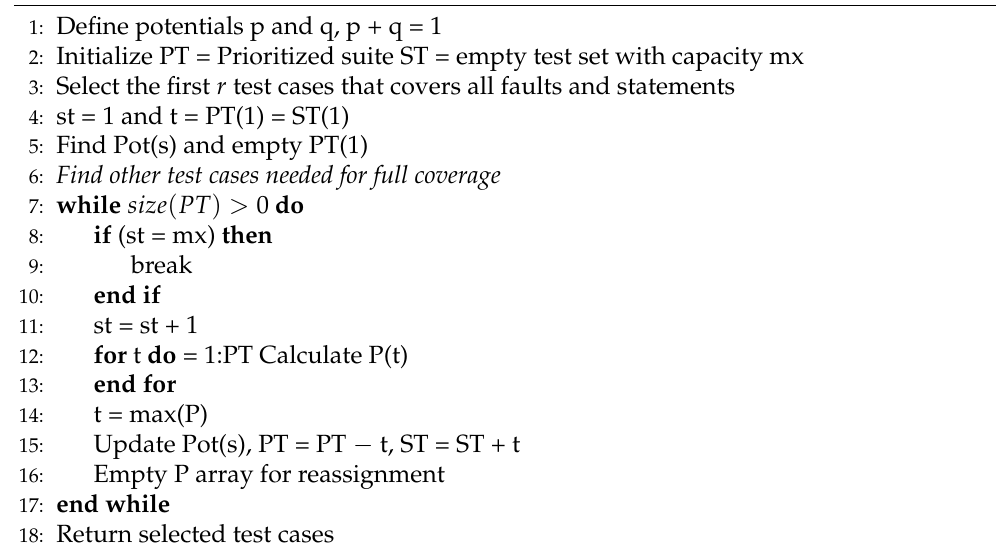
Algorithm 1 Adaptive Test Case Selection (ATCS)